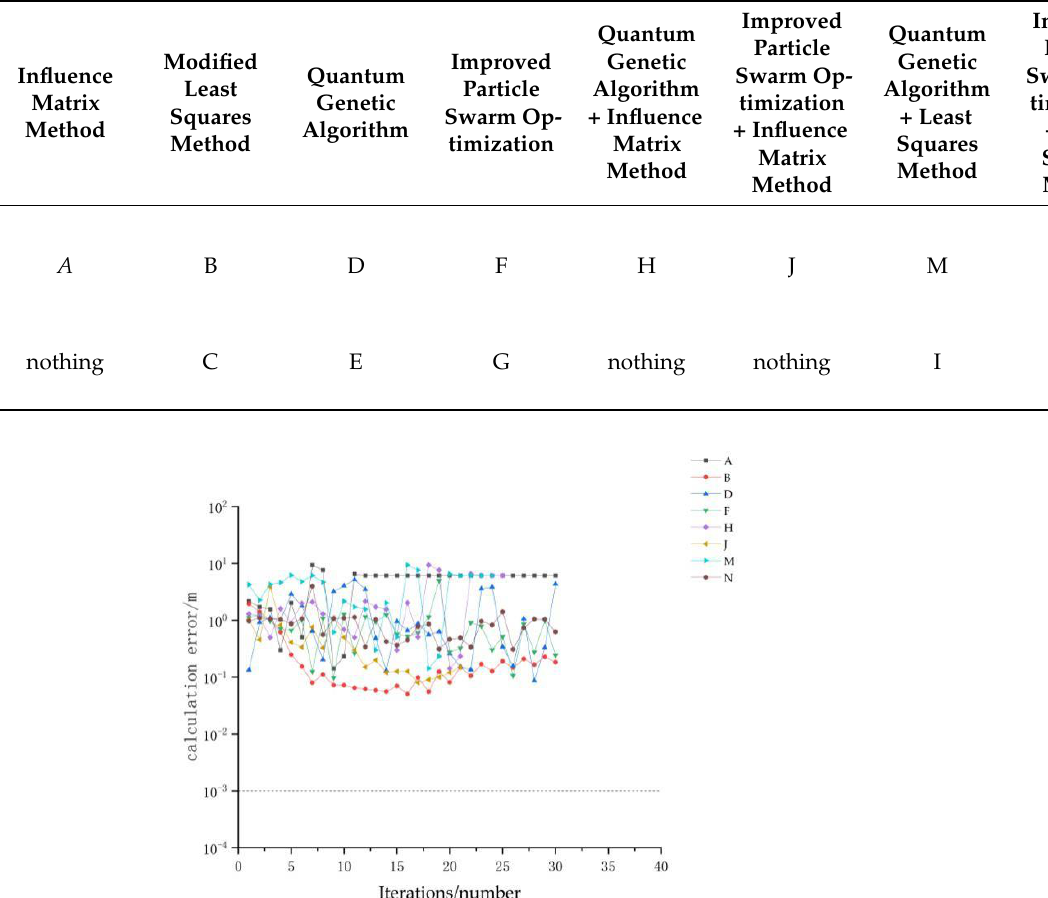
Table 3. Algorithms under different calculation models.